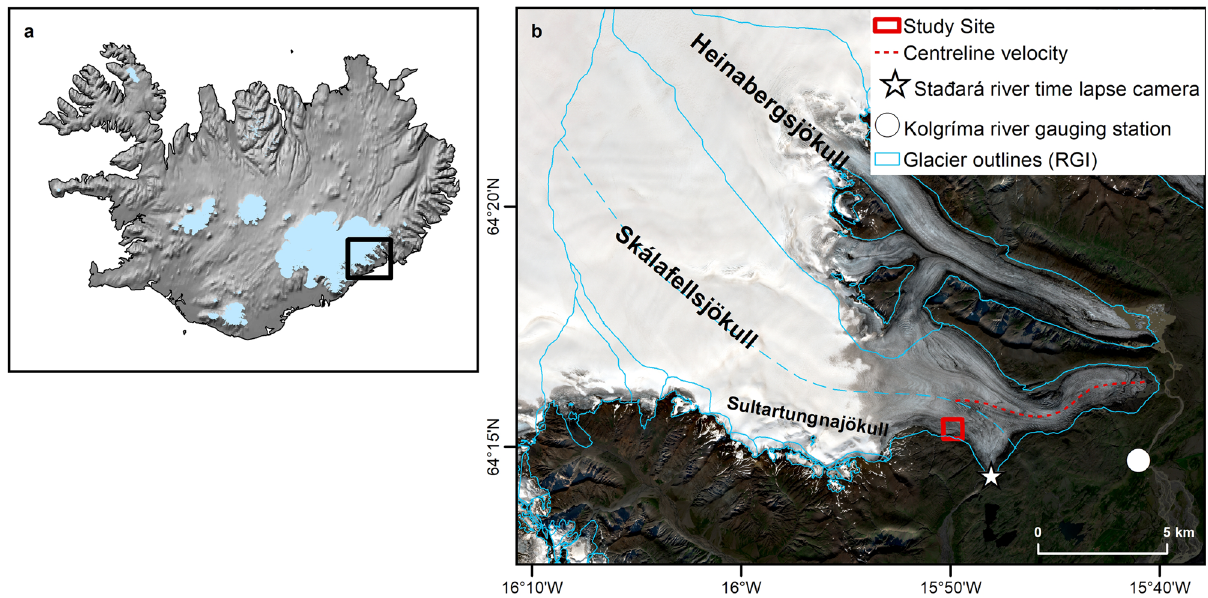
Fig. 1 Details of the fi eld site. a location within Iceland. b detail of Skálafellsjökull ( fi eld site shown with a box). Discharge measurement sites are shown; Sta đ ará river time-lapse camera (star) and Kolgríma river gauging station V520 (circle). Glacier outlines from Randolph Glacier Inventory 6.0. Image is Sentinel-2 natural look colour composite from 30 August